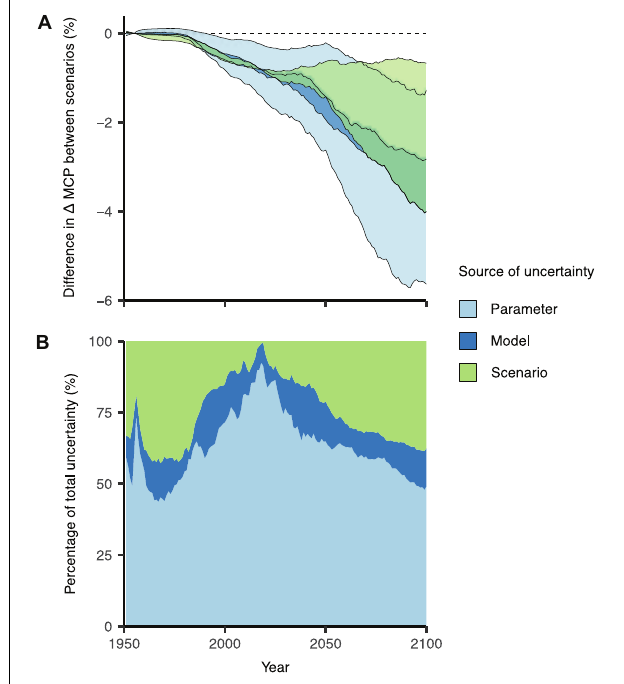
FIGURE 6 | Testing model variability for the projected impacts on maximum catch potential (MCP) due to ocean acidification (OA). (A) Projected changes using the upper and lower bounds of parameter, model, and scenario uncertainty; and (B) the proportion of total uncertainty allocated to each source of uncertainty. Default conditions held constant when testing each source of uncertainty were: (1) parameter = mean OA effect size; (2) model = GFDL-ESM2M; and (3) scenario = RCP 8.5. Results are smoothed by 10-year running means and relative to the 1951–1960